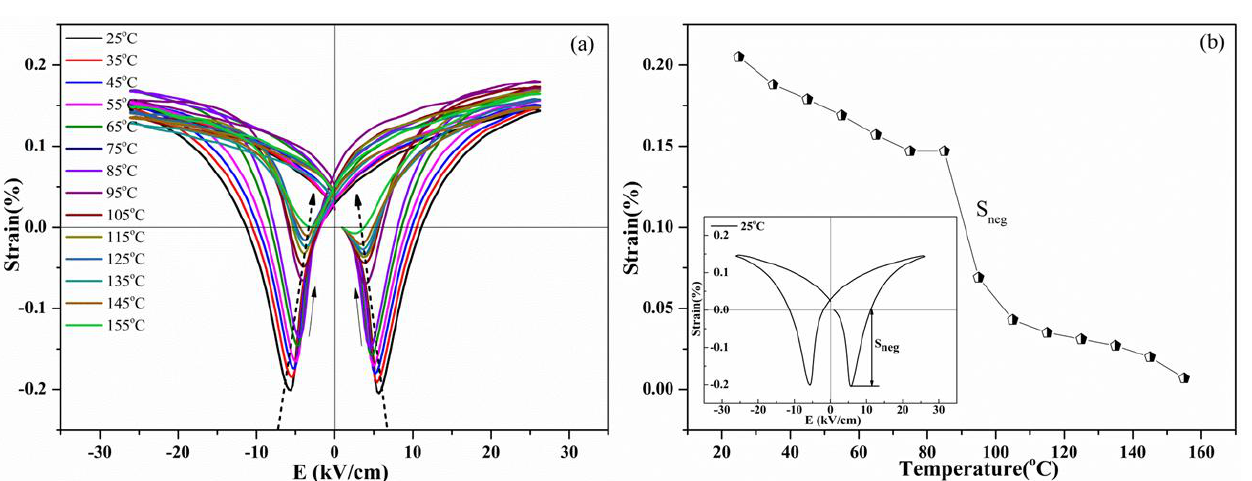
Figure 4. ( a ) Variable temperature S-E hysteresis loop patterns; ( b ) Negative strain (S values as a function of temperature. The inner indicates the definition of S